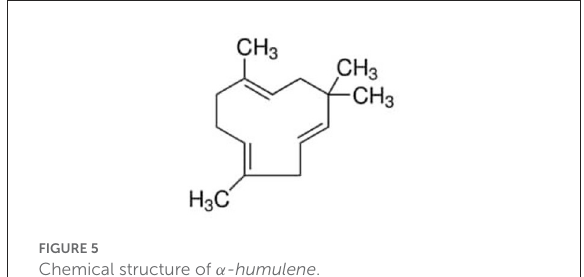
FIGURE5 Chemical structure of α -humulene